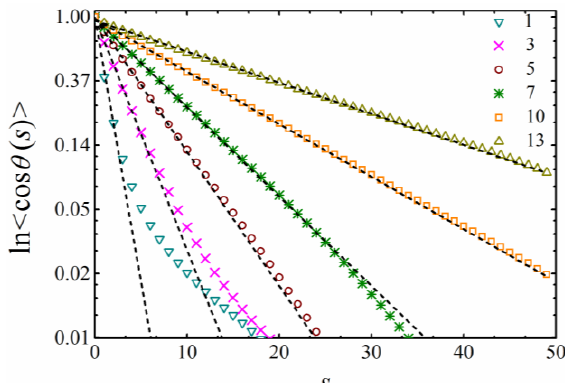
Figure 3. The orientation correlation function as a function of the chemical distance s along the chain with an indicated bending constant k . The dashed lines indicate the fits of the initial decay.